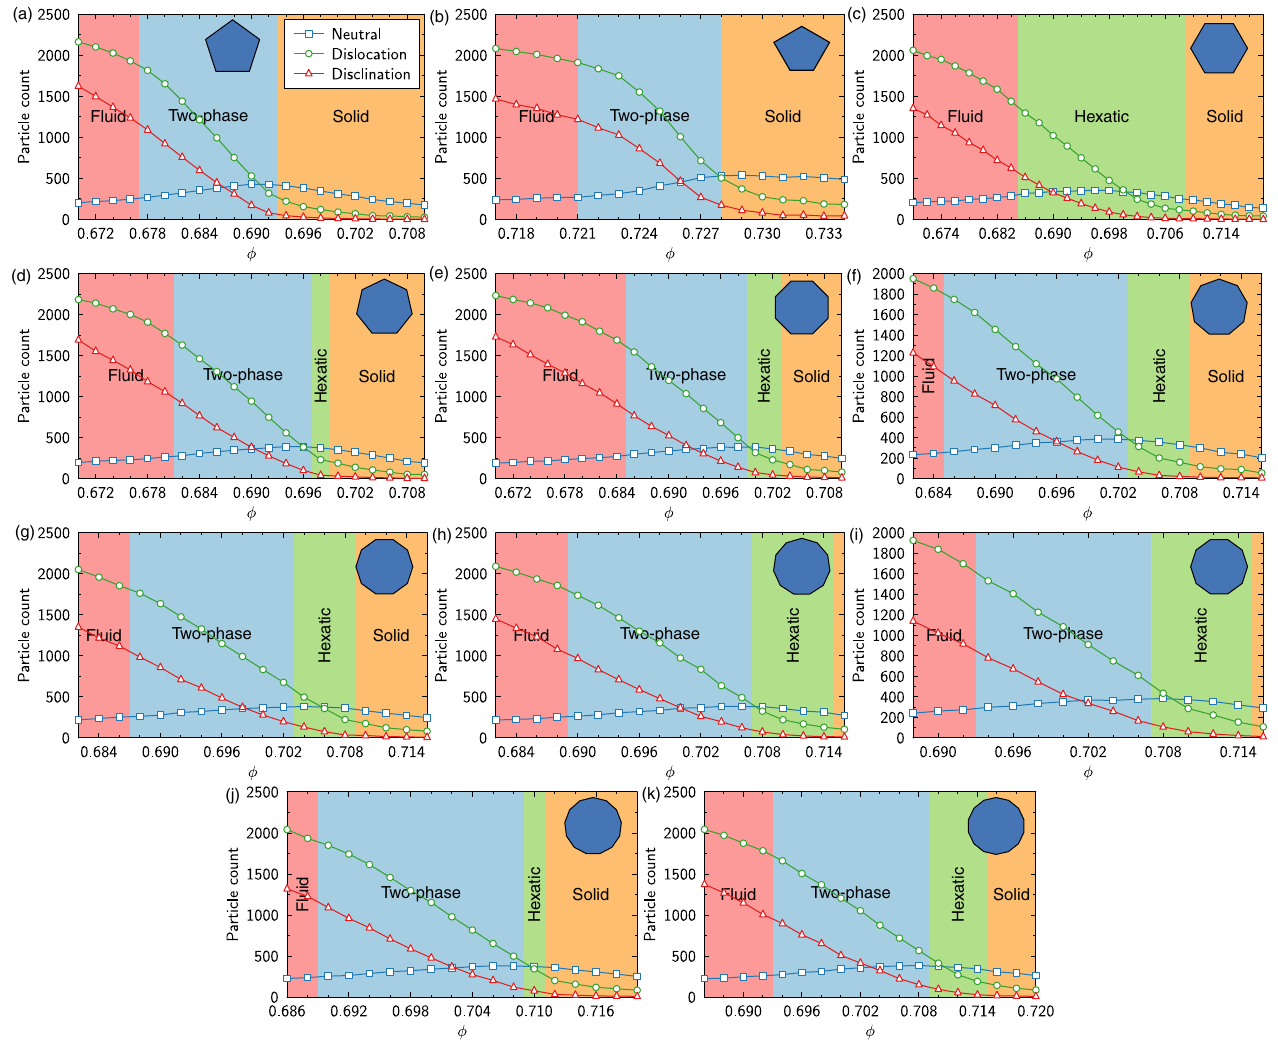
FIG. 4. Defect countsasa functionofdensityobtainedwith cell-edgecounting.Theparticlecount isthenumberofparticlesthatbelongto any defect cluster classified into neutral, Burgers-charged, and disclination-charged clusters. The panels show results of the defect analysis plots for polygons n ¼ 5 (a), 5 (cid:2) (b), 6 (c), 7 (d), 8 (e), 9 (f), 10 (g), 11 (h), 12 (i), 13 (j), and 14 (k), averaged over 4 – 8 runs with 19 – 49 frames per run at the system size N ¼ 128 2 . The defect count algorithm is expensive, sowe do not run it on the largest size simulations we perform. We also show the phase diagram overlaid on the counts. Error bars at 1 standard deviation are smaller than the symbol